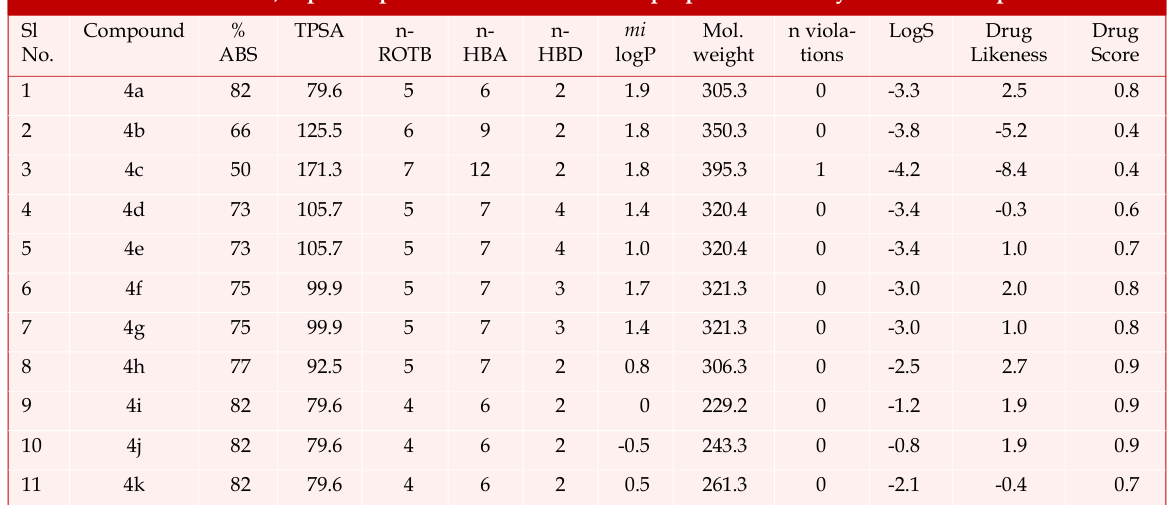
Predicted ADME, Lipinski parameters and molecular properties of the synthesized compounds Sl